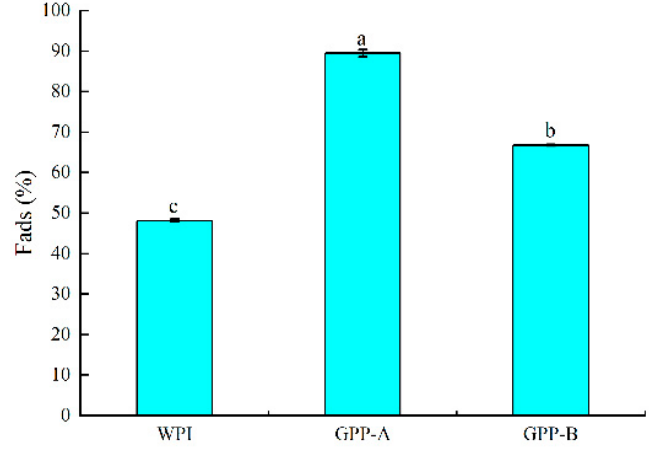
Figure 4. Changes in fraction of interfacial adsorption (Fads) of CLA emulsions stabilized by GPP-A and GPP-B. Values with different letters are significantly different ( p < 0.05).